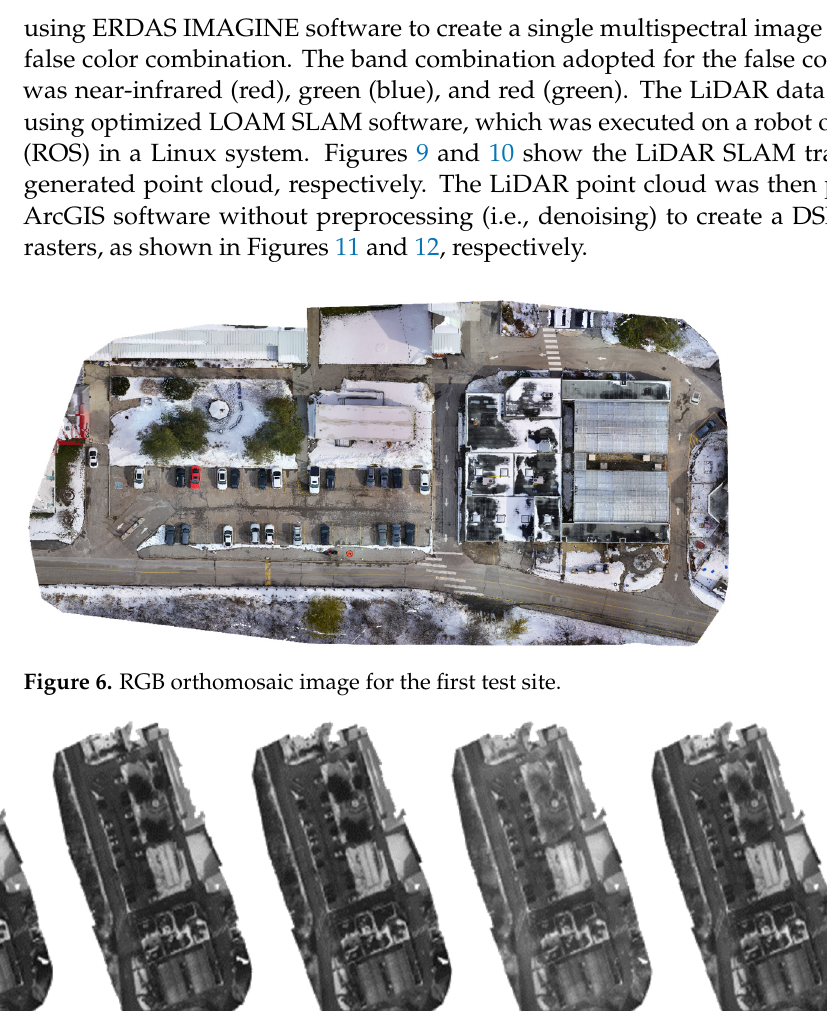
Figure 5. UAS flight lines above the second test site.